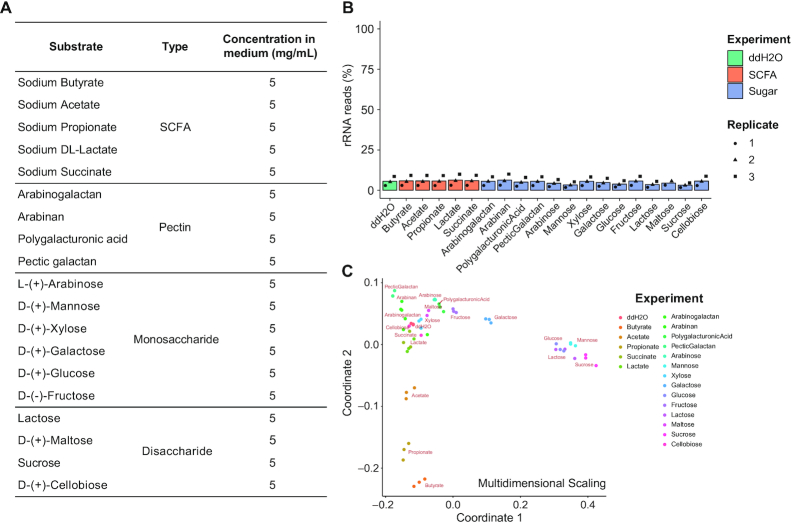
High-throughput microbial RNA-seq screening of Bacteroides dorei on different substrates. (A) The 5 short-chain fatty acids (SCFAs) and 14 carbohydrates tested. B. dorei cultures were treated with each substrate at 5 mg/ml final concentration during exponential growth phase. (B) The RNase H-based method showed efficient and consistent rRNA depletion on pooled RNA samples from different conditions. Three biological replicates were performed for each condition. (C) Multidimensional scaling ordination of 20 conditions based on overall transcriptomes. Pairwise Spearman correlations between conditions were calculated using expression profiles and multidimensional scaling was then performed on normalized Spearman correlations to visualize the impact of substrates on bacterial transcriptome.